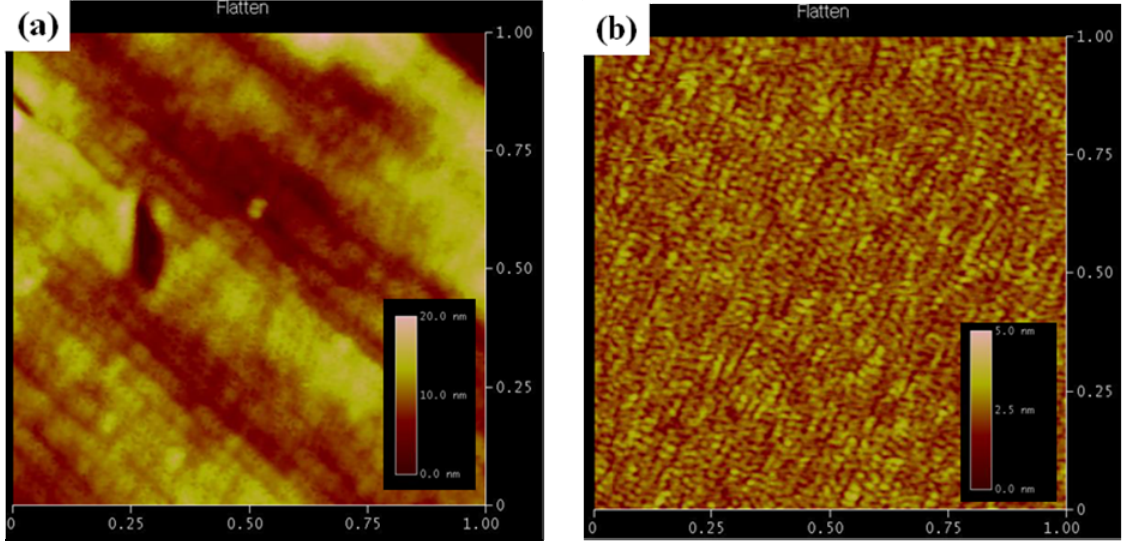
Figure 1. Atomic force microscope (AFM) topography of gold films sputtered on (a) nanoporous niobium oxide and (b) wafer. The sputtering of gold on both substrates was conducted for 30 s at 40 mA by a magnetron sputter (MSP-1S, Vacuum Device Inc.,